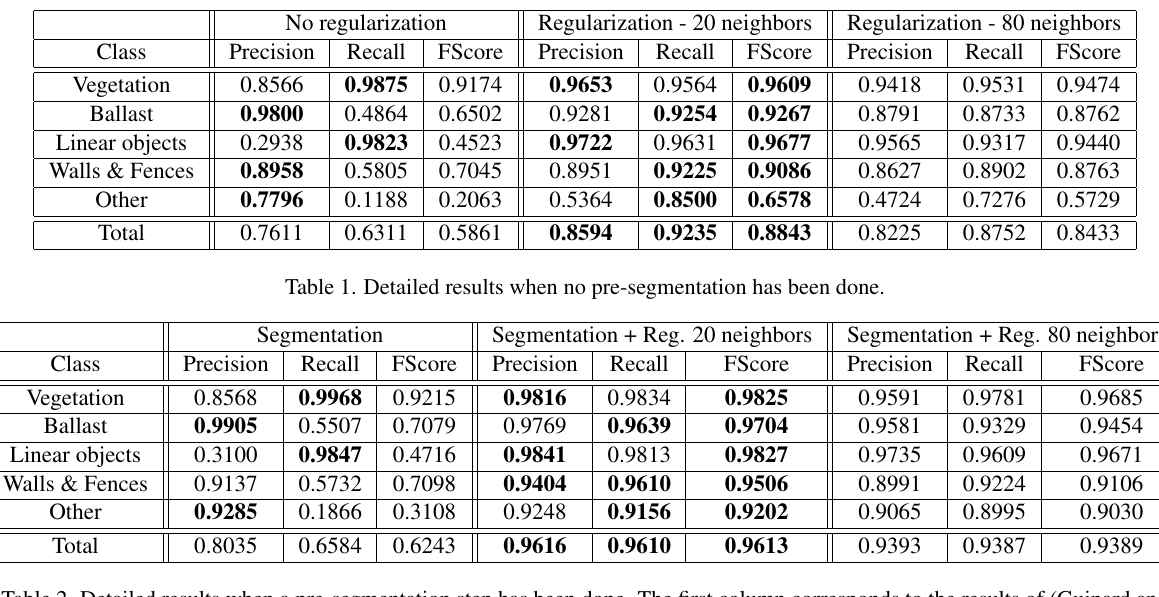
Table 2. Detailed results when a pre-segmentation step has been done. The first column corresponds to the results of (Guinard and Landrieu,